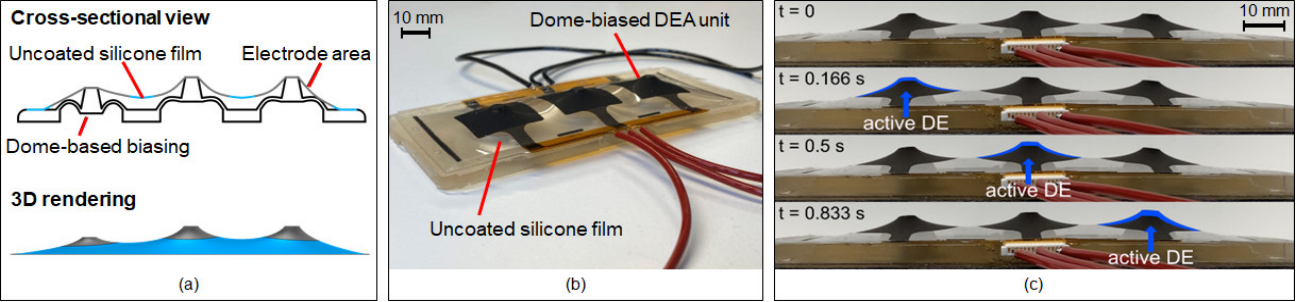
Figure 3. 3 × 1 DEA membrane w/polymeric dome bias, schematic side view ( a ), 3 × 1 DEA membrane w/ polymeric dome bias, full view ( b ), 3 × 1 DEA membrane w/polymeric dome bias, simple wave propagation ( c ).